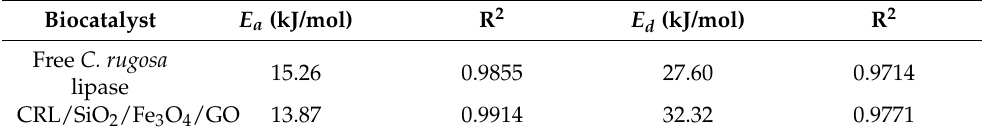
Table 1. Summary of activation and deactivation energies of free CRL and CRLSiO 2 /Fe 3 O 4